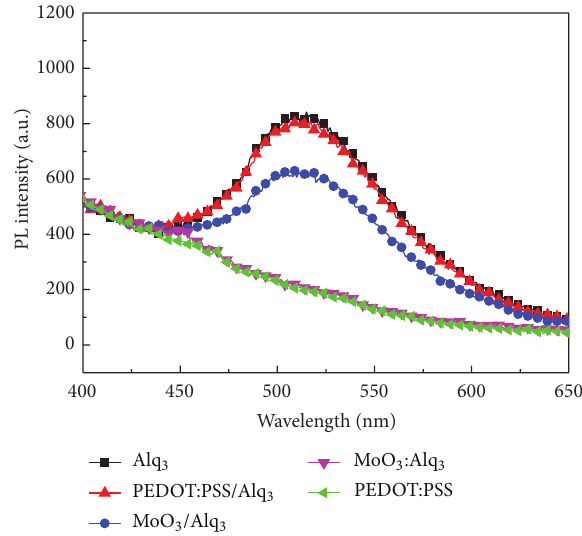
Figure 1: Photoluminescence spectra of five thin films: Alq 3 , PEDOT:PSS, PEDOT:PSS/Alq 3 , molybdenum trioxide MoO 3 /Alq 3 , and MoO 3 : Alq 3 (1: